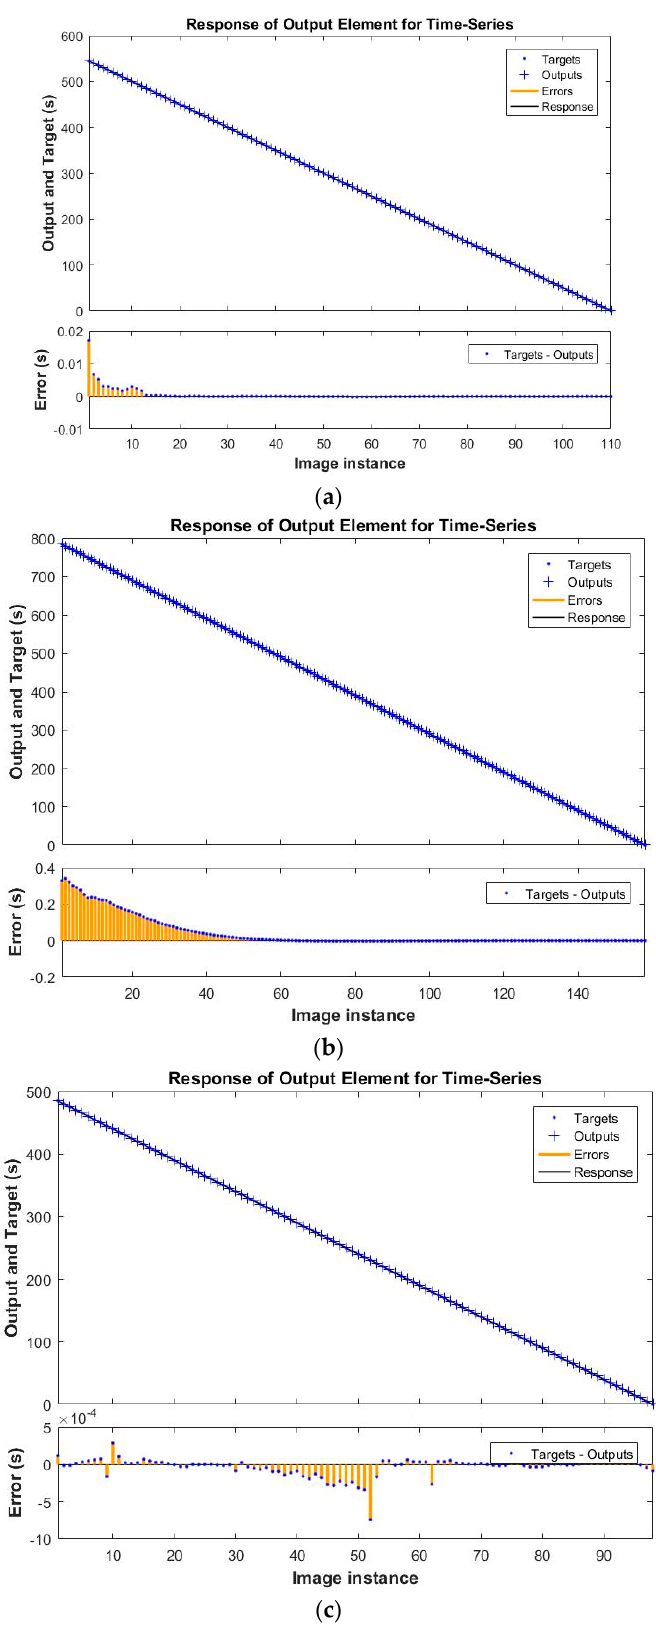
Figure 18. NARX Neural Network response of output element. Results refer to three best configurations in predicting cleaning time for Dataset D1 ( a ); D2 ( b ) and D3 ( c ).